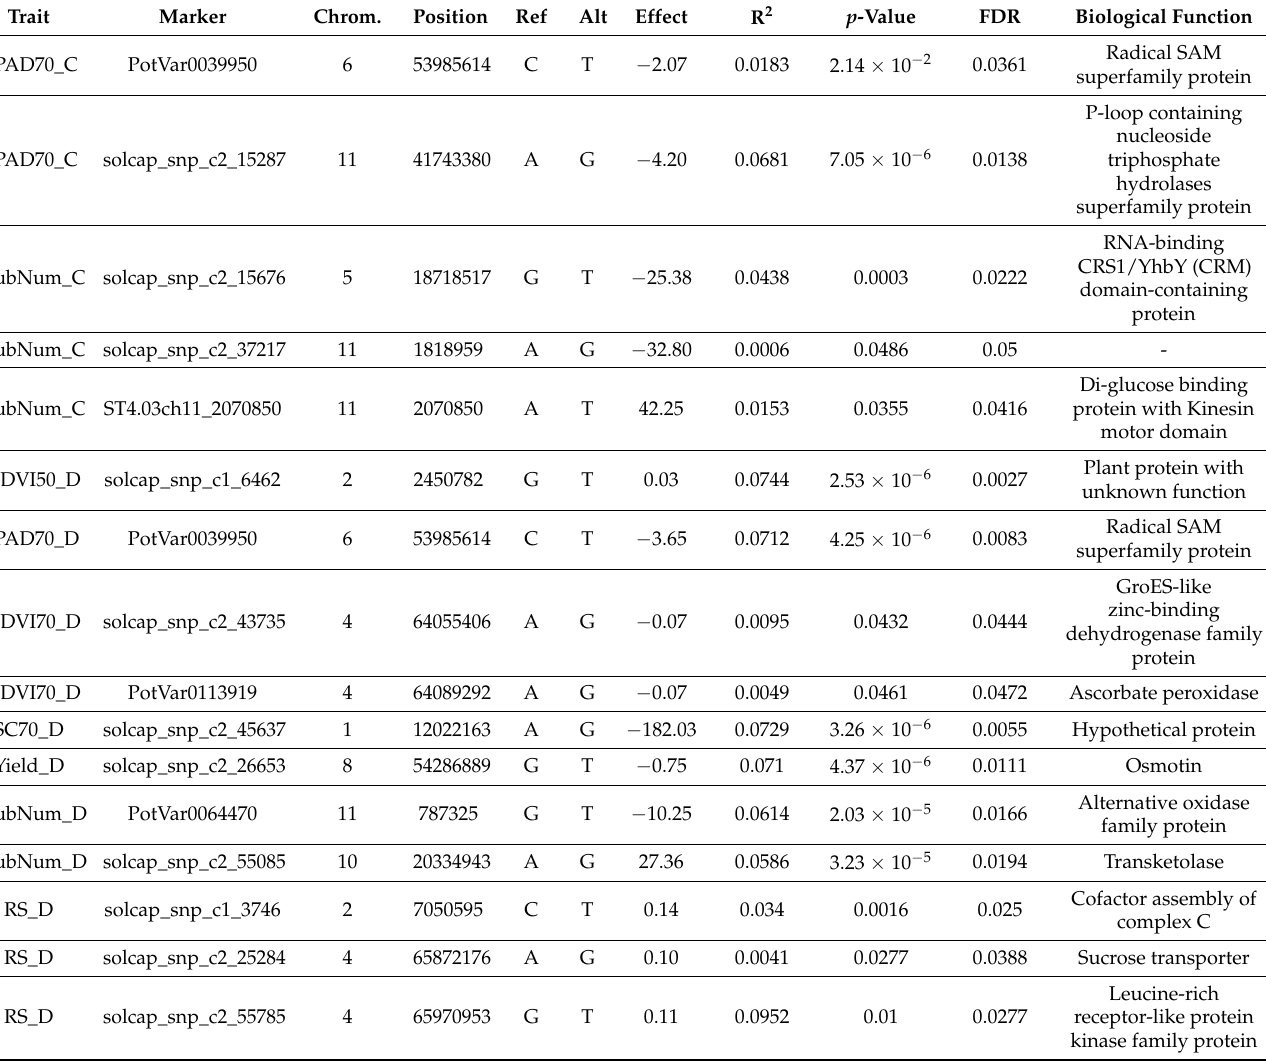
Table 3. Significant SNPs associated with evaluated physiological and agronomical traits under control and drought stress conditions in 144 potato